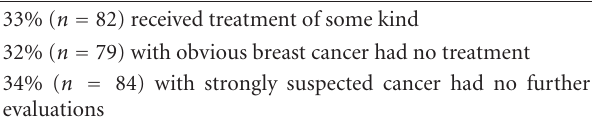
Table 3: Treatment received in 245 rural Bangladeshi women with obvious or strongly suspected breast